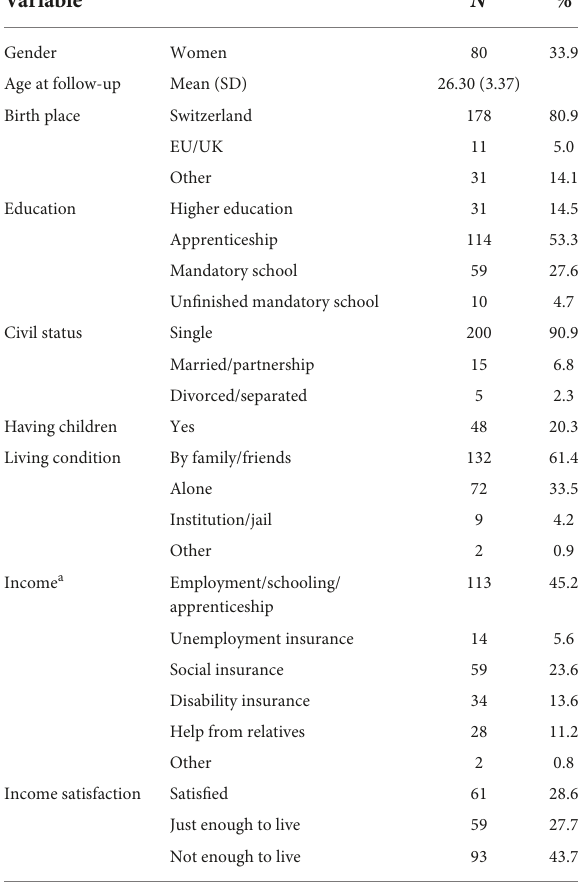
TABLE 1 Socio-demographic characteristics ( n =